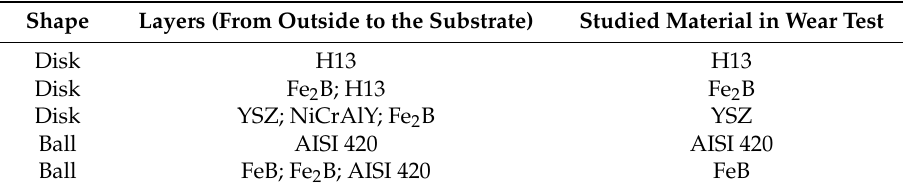
Figure 3. X-ray diffractogrammes of the layer obtained by boriding H13 steel, after cleaning. The positions denoted by (+) show what would be the FeB diffractogramme. Table 1. Summary of the studied samples.